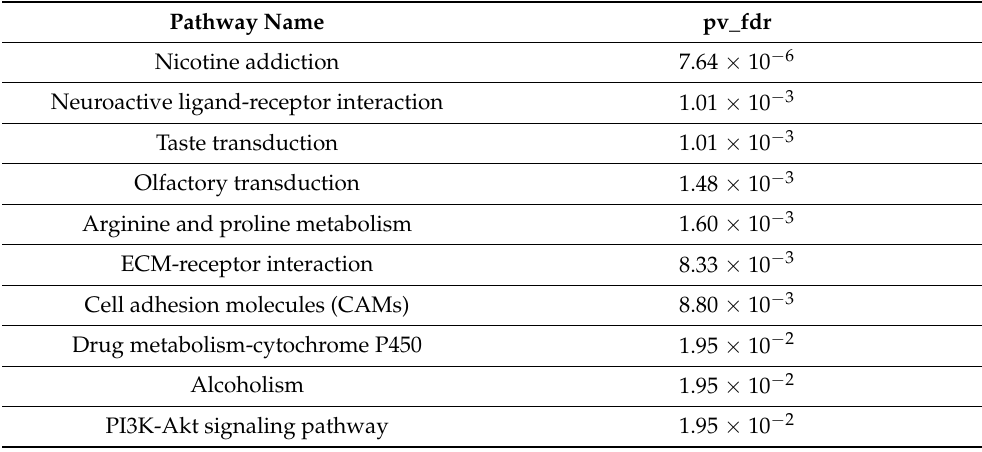
Table 2. Analysis of Impacted Pathways between AA and EA men.